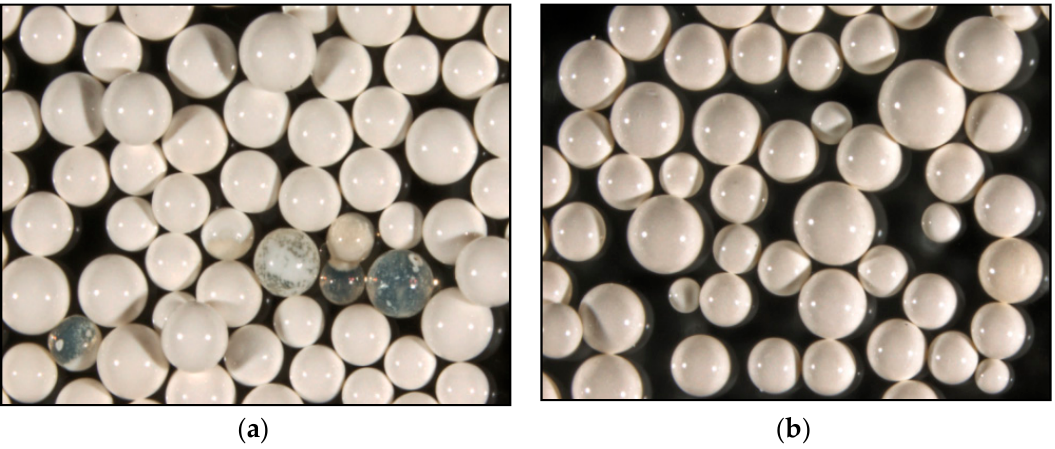
Figure 2. Photographs of ( a ) Purolite S 940, ( b ) Purolite S 950.